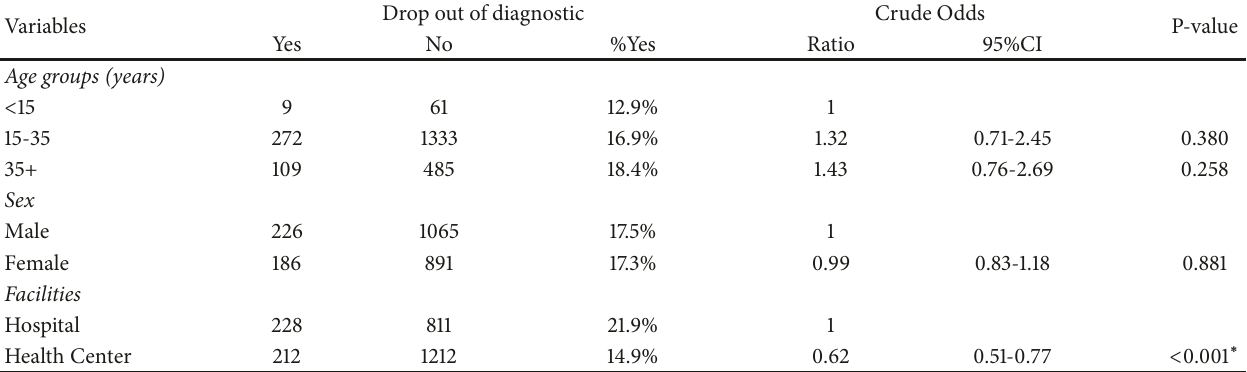
Table 4: Determinants on sputum smears positive pulmonary tuberculosisdiagnostic dropout ratein public health facilities, in Addis Ababa, Ethiopia; from 2011 to